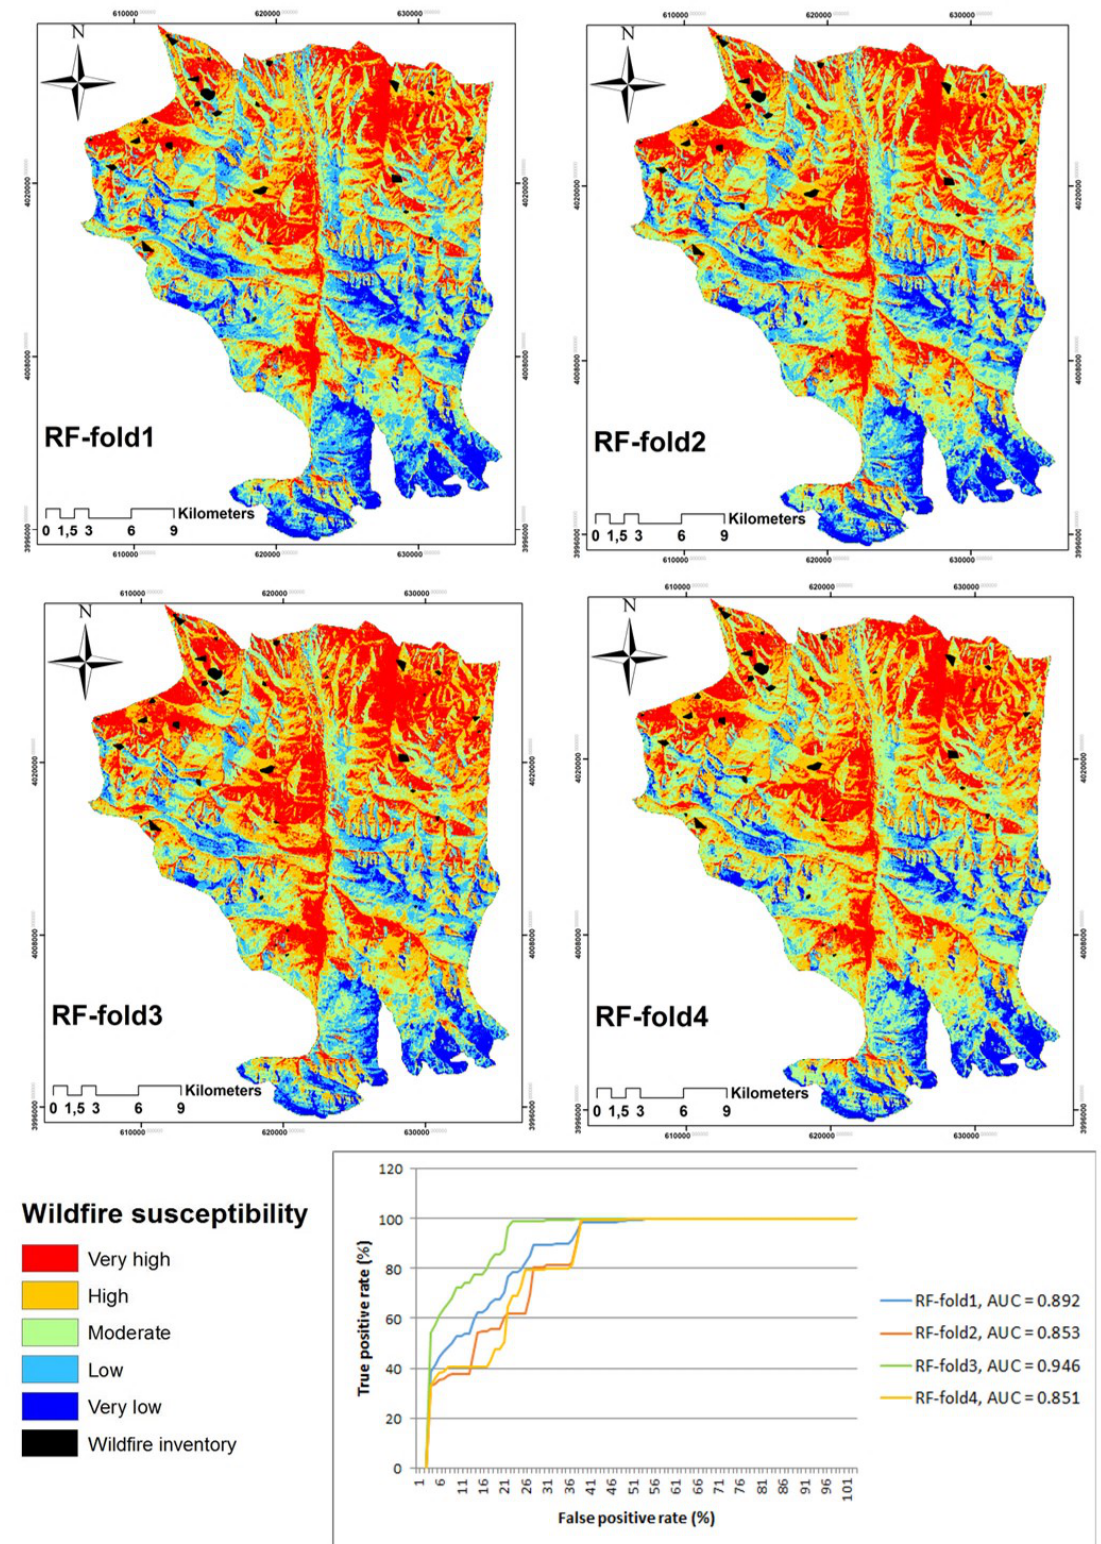
Figure 8. Spatial prediction of wildfire susceptibility maps using RF and the AUC results based on four-fold